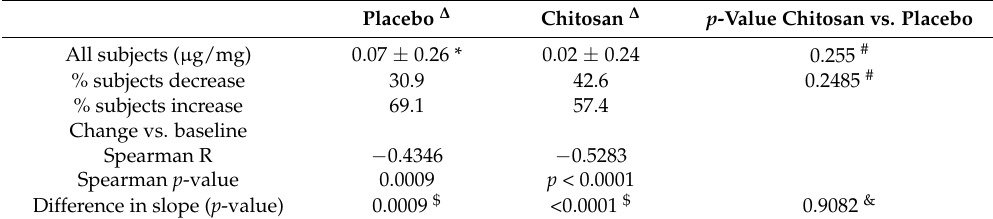
Table 9. Comparison of changes in serum R_cholestanol induced by chitosan and placebo treatments. Placebo ∆